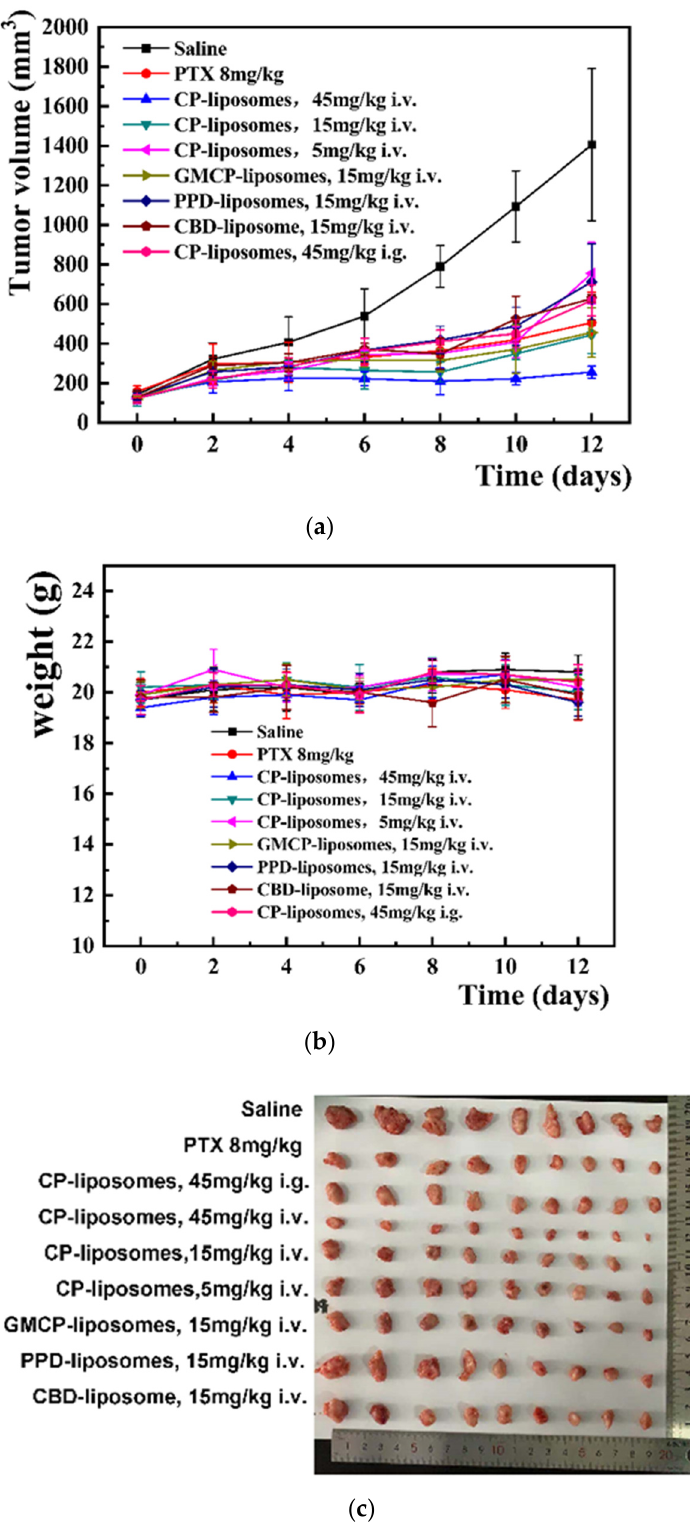
Figure 5. The in vivo anti-tumor efficacy of CBD-liposomes, PPD liposomes, CP-liposomes, GMCP- liposomes. ( a ) for tumor volume change curves, ( b ) for body weight change curve and ( c ) for the actual tumor image collected at the end of the experiment.